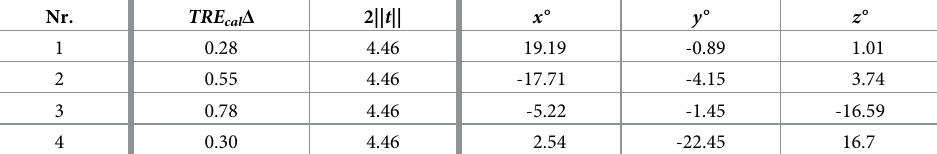
Table 7. Additional error TRE introduced by the perturbation t and upper bound. Orientations/angles (degree) cal Δ of the transducer between the first scan and the other scans.